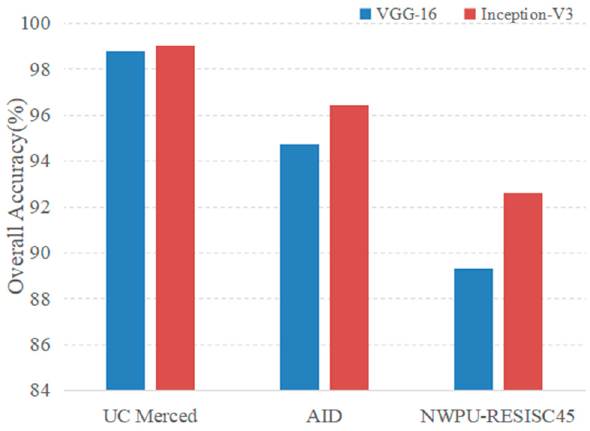
Figure 14. The influence of pretrained CNN models on the classification accuracy.